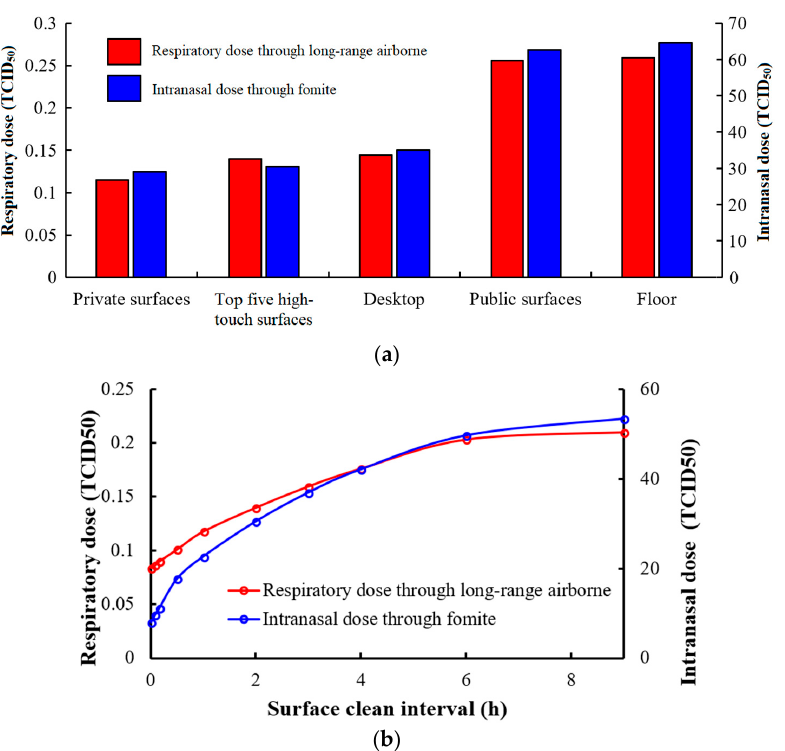
Figure 9. Surface cleaning. ( a ) Various types of surfaces with a cleaning frequency of 0.5 h − 1; ( b ) different clean interval for top five high ‐ touch surfaces 1 . 1 Top five high ‐ touch surfaces: desktop, ( b ) different clean interval for top five high-touch surfaces 1 . 1 Top five high-touch surfaces: desktop, mouse, mobile phone, keyboard and chair arms. mouse, mobile phone, keyboard and chair